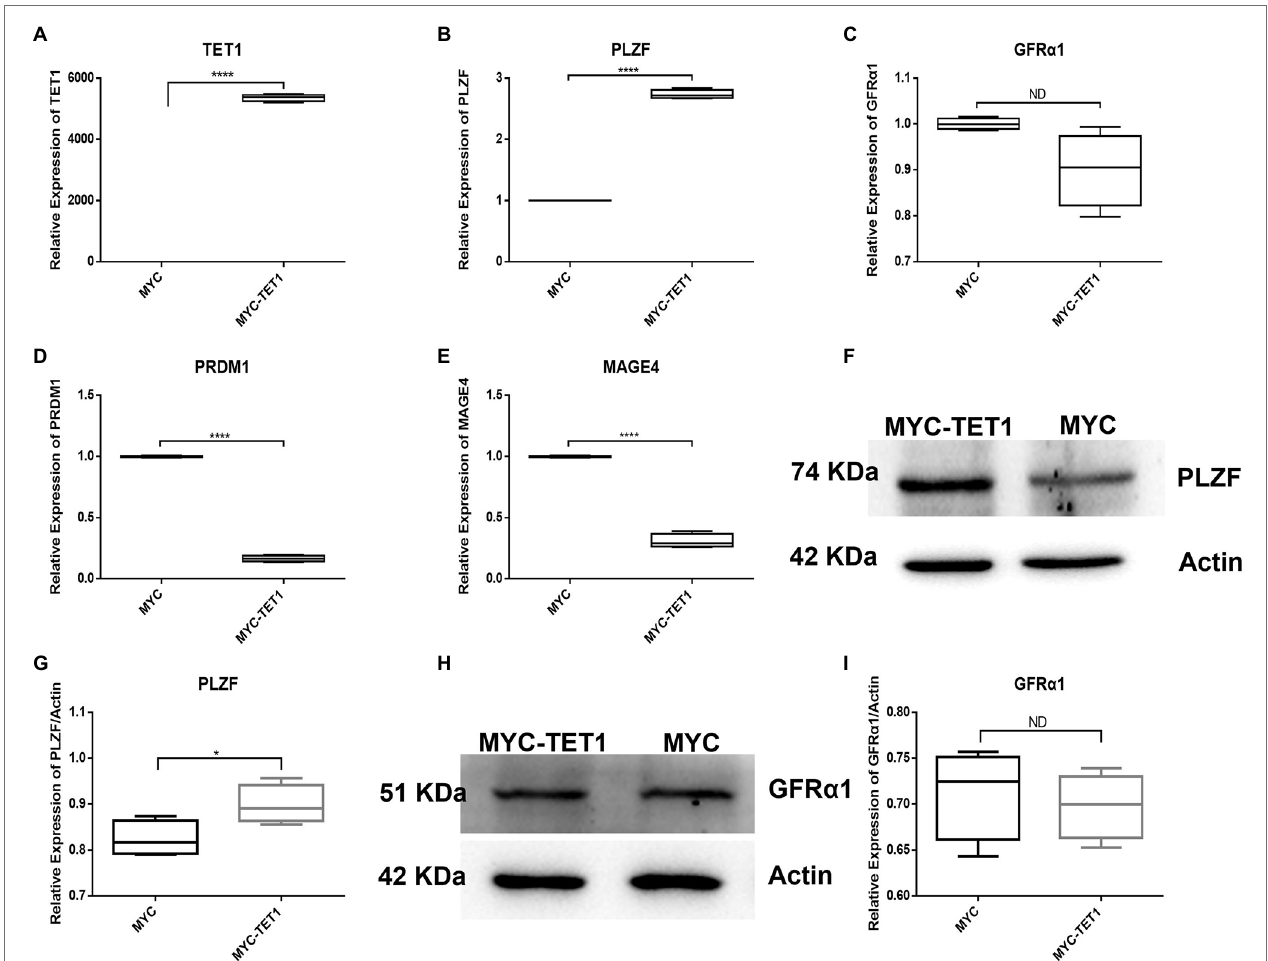
FIGURE 1 | Relative expression of specific genes in spermatogonial cells. (A) The mRNA expression of TET1 in spermatogonial cells was detected by QRT-PCR. (B) The mRNA expression of PLZF in spermatogonial cells was detected by QRT-PCR. (C) The mRNA expression of GFR α 1 in spermatogonial cells was detected by QRT-PCR. (D) The mRNA expression of PRDM1 in spermatogonial cells was detected by QRT-PCR. (E) The mRNA expression of MAGE4 in spermatogonial cells was detected by QRT-PCR. (F) The expression of PLZF in TET1 overexpressed cells was detected by Western Blot. (G) Quantification of PLZF protein levels in TET1 overexpressed cells. (H) The expression of GFR α 1 in TET1 overexpressed cells was detected by Western Blot. (I) Quantification of GFR α 1 protein levels in TET1 overexpressed cells. p < .0001(****), p < .001(***), p < .01(**), p <